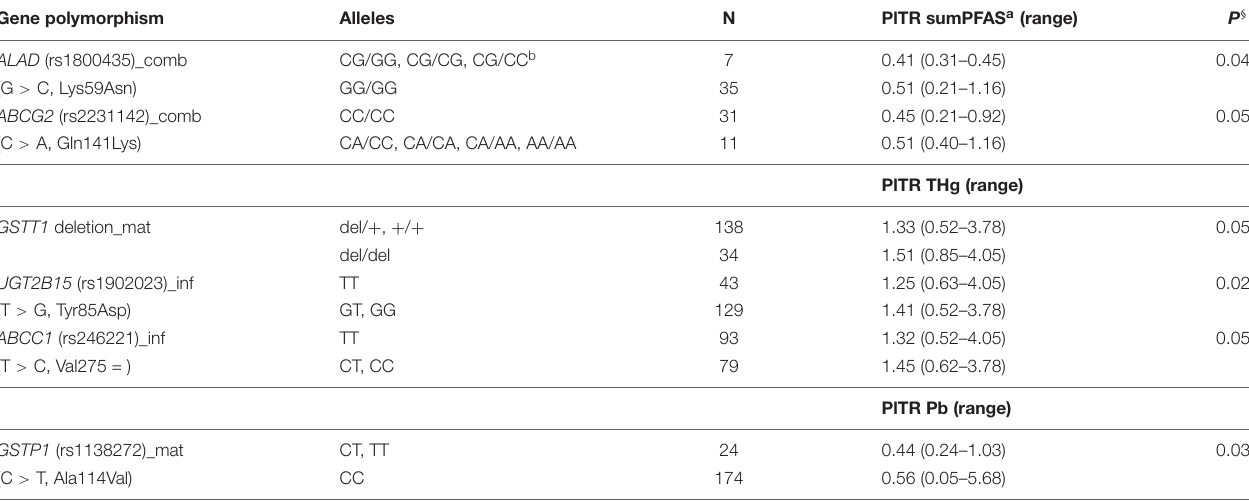
TABLE 4 | Genotypes associated with placental transfer rates (PlTR) in bivariate statistics. Gene polymorphism Alleles